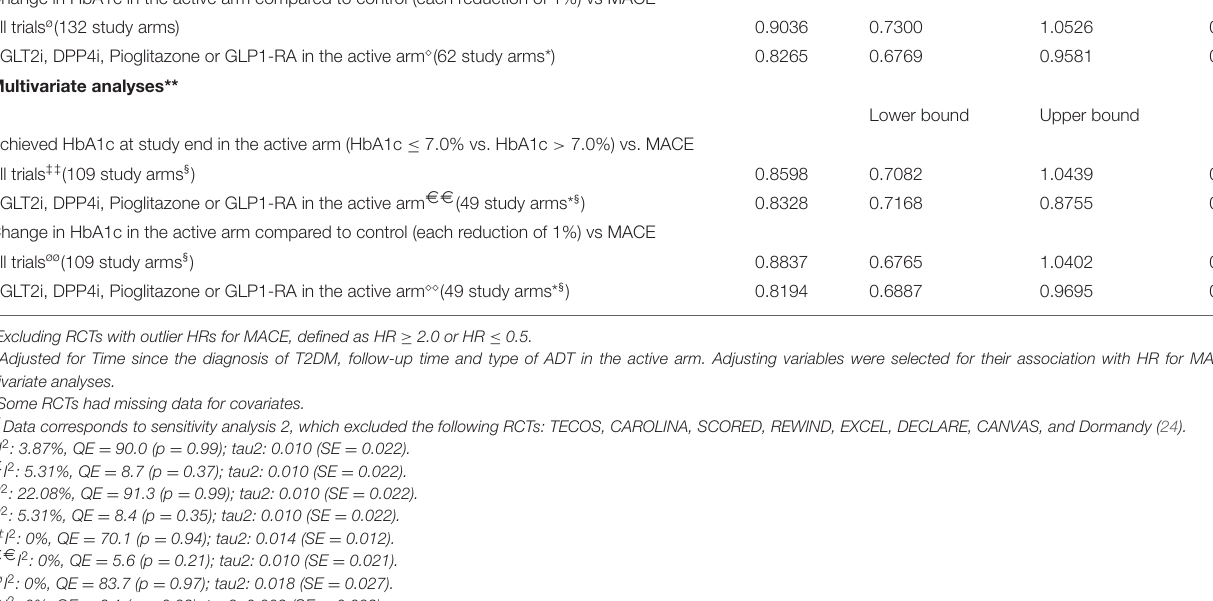
TABLE 3 | Sensitivity analyses U using meta-regression models for the hazard ratio of MACE as dependent variable. Bivariate